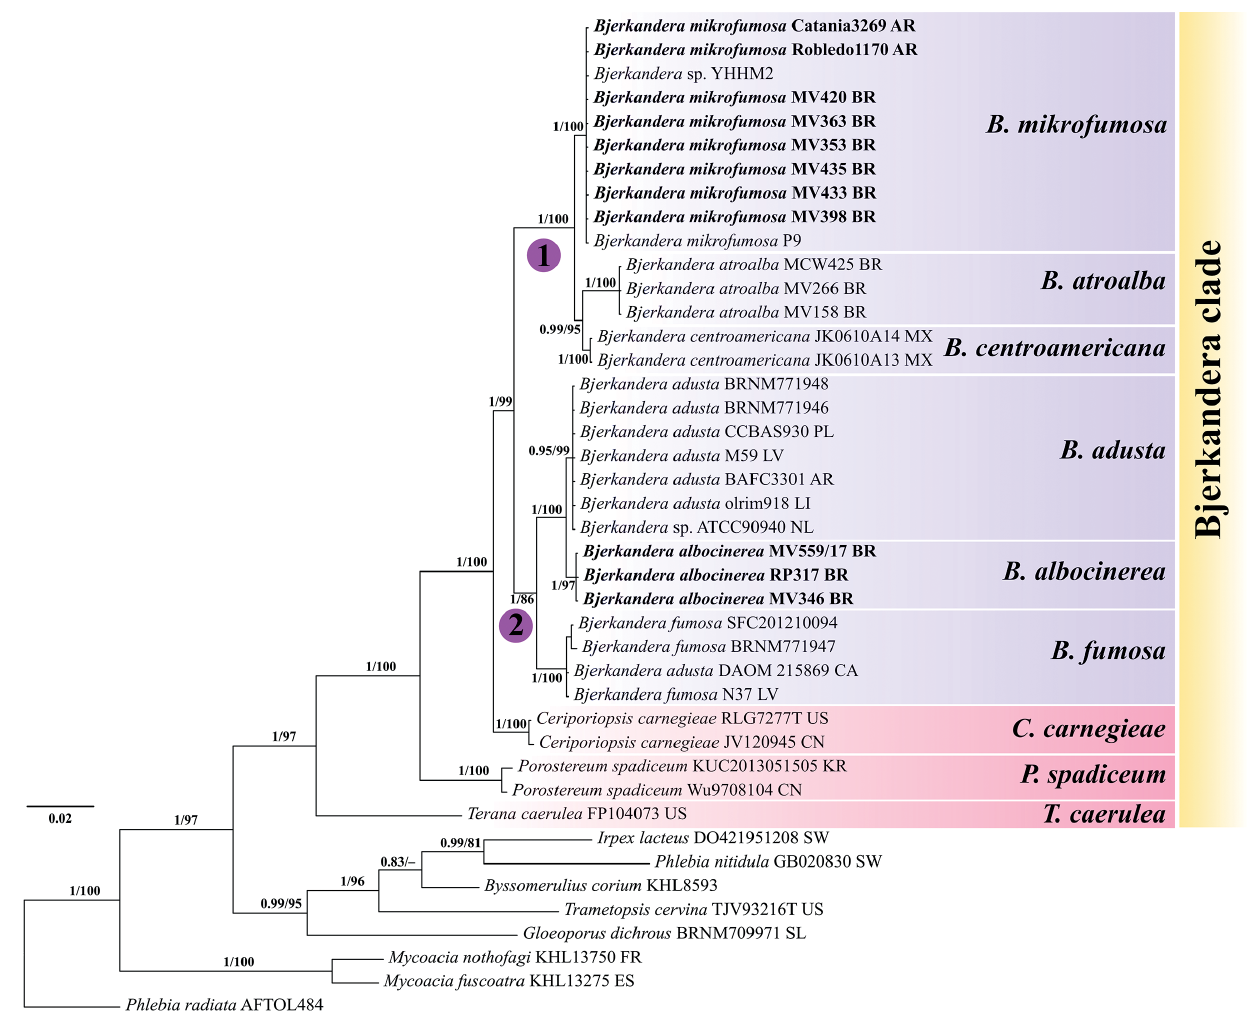
Figure 1 – Phylogenetic relationships of Bjerkandera species inferred from a combined dataset of ITS and nLSU sequences. The topology is recovered from the BI analysis with PP/BS support values given at the nodes. All sequences obtained in this study are in bold. The bar indicates the number of expected substitutions per